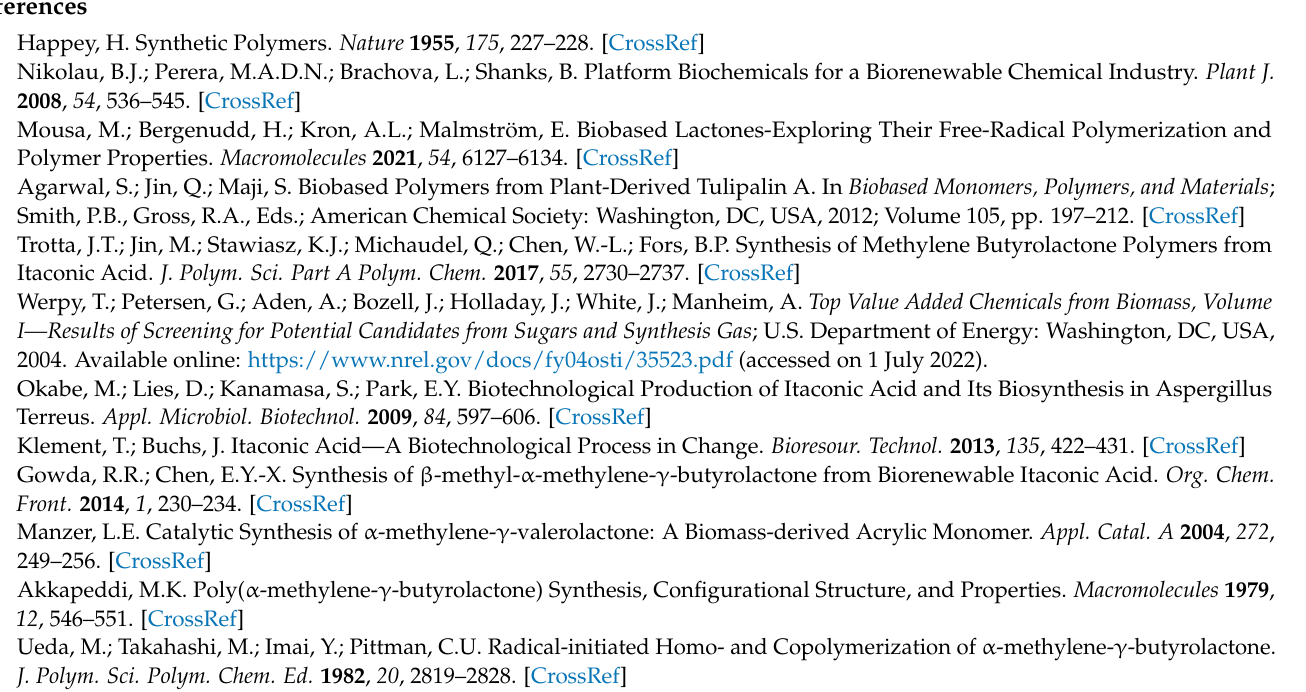
setup; Figure S2: iCVD laboratory setup at University of Groningen, Netherlands; Figure S3: Pre- liminary experiment: Effect of the substrate position on the iCVD stage on the rate of deposition; Figure S4: Compiled FTIR spectra of all the polymer spectra ( P m / P sat = 0.3 – 0.7); Figure S5: Stack plot for the 1 H NMR spectrum of PMBL samples; Figure S6: MWDs of PMBL (obtained via SEC using PMMA standards): For the samples P0.52a, P0.61a, P0.70a in Table 1); Figure S7: Mechanical properties: nanoindentation data – Displacement vs load curve; Figure S8: Mechanical properties: Displacement vs load diagram (five randomly chosen curve compilation); Figure S9: Nanoindenta- tion results for multiple samples: PMBL modulus; Figure S10: Nanoindentation results for multiple samples: PMBL hardness; Figure S11: DSC data for samples P3 and P4; Table S1: Peak assignments for FTIR spectrum; Table S2: Nanoindentation